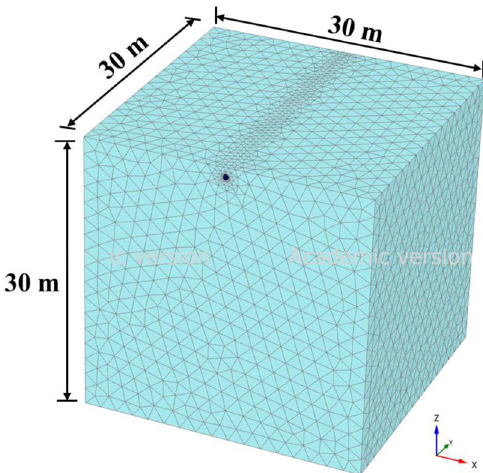
Figure 4. Mesh discretization of three-dimensional finite element model.